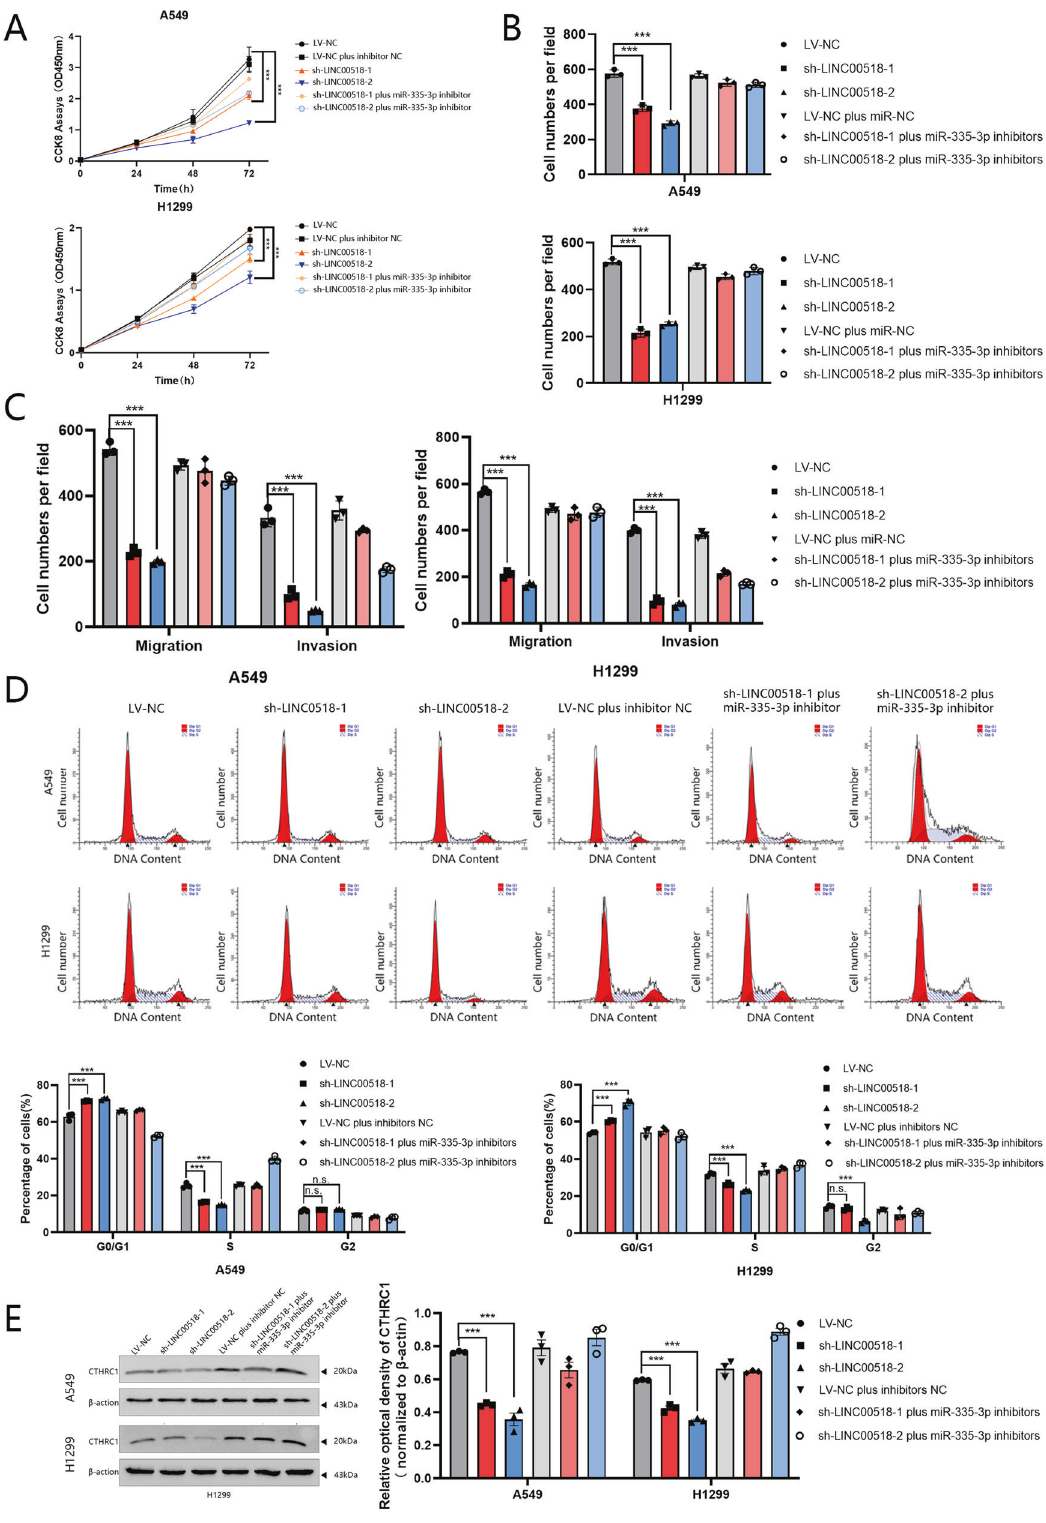
Fig. 7 LINC00518 promotes LUAD cell proliferation and metastasis through the miR-335-5p/CTHRC1 axis. A – B CCK-8 assay and colony formation analysis were applied to detect the proliferation of A549/H1299 cells transfected with LINC00518 shRNA, LINC00518 shRNA plus miR-335-3p inhibitor, or the control. C The effect on LUAD cell migration and invasion following transfection is tested by transwell assay. D Cell cycle distributions were analyzed in A549 and H1299 cells by fl ow cytometry. E Western blots identi fi ed the protein expression changes in LINC00518 shRNA and LINC00518 shRNA plus miR-335-3p inhibitor transfected LUAD cells. β -actin was used as a control. All results indicate SD. (* P < 0.05, ** P < 0.01, *** P < 0.001).